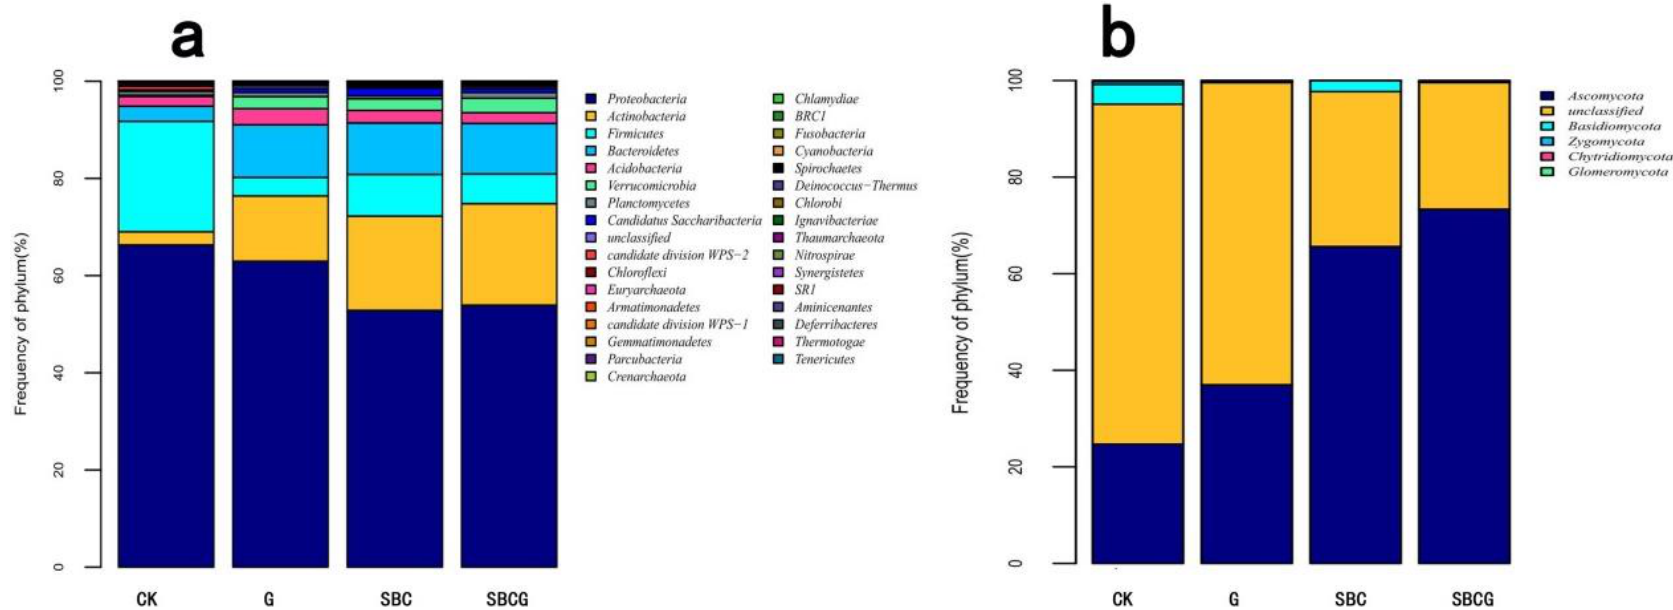
Figure 3. Frequency of bacterial ( a ) and fungal ( b ) phyla detected in IAC mining wasteland soil in the un-amended control (CK), alfalfa revegetation (G), sludge biochar amendment (SBC), and combined amendment (SBCG) treatments. Abundance is presented in terms of the average percentage, classified by Ribosomal Database Project (RDP) classifier at a confidence threshold of 80%. “Other” refers to the sum of unclassified sequences and all other taxa with abundances < 0.9% in any